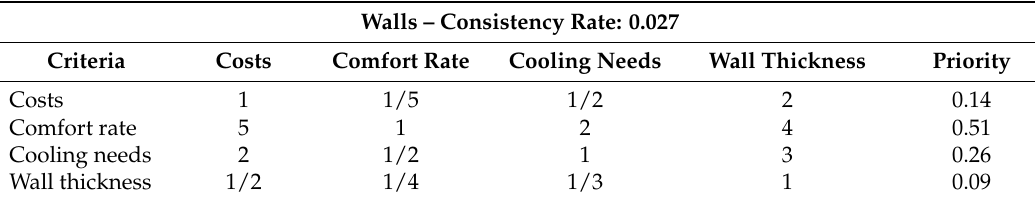
Table 7. Pairwise comparison matrix of criteria for walls.